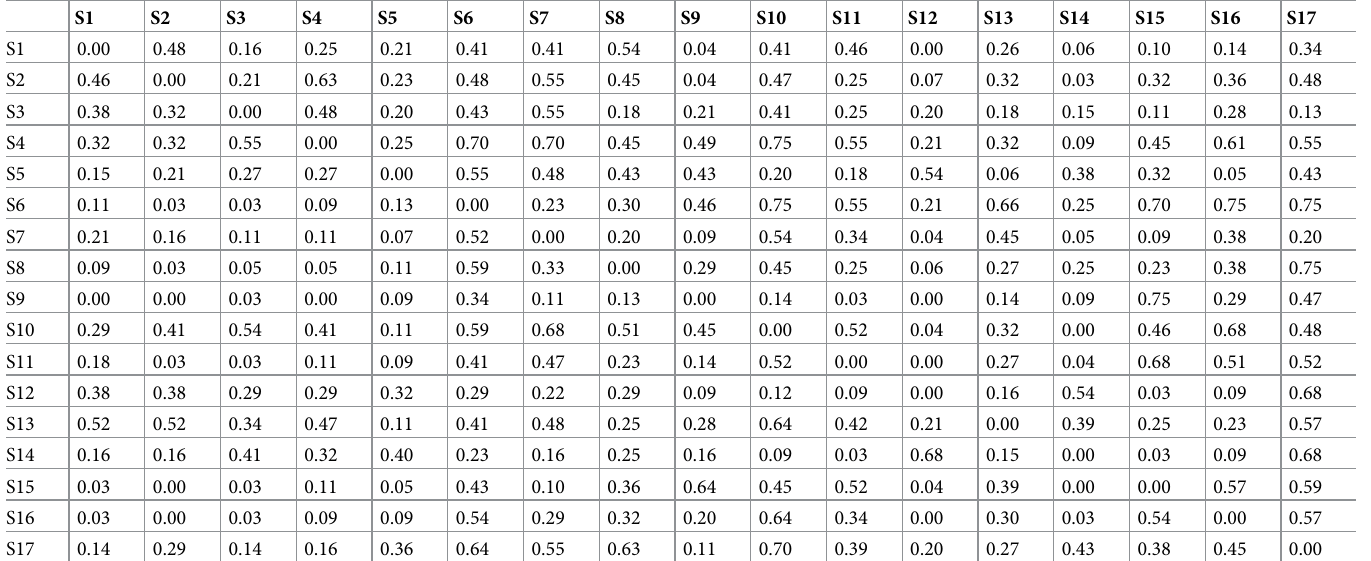
Table 8. The direct influence matrix Z.